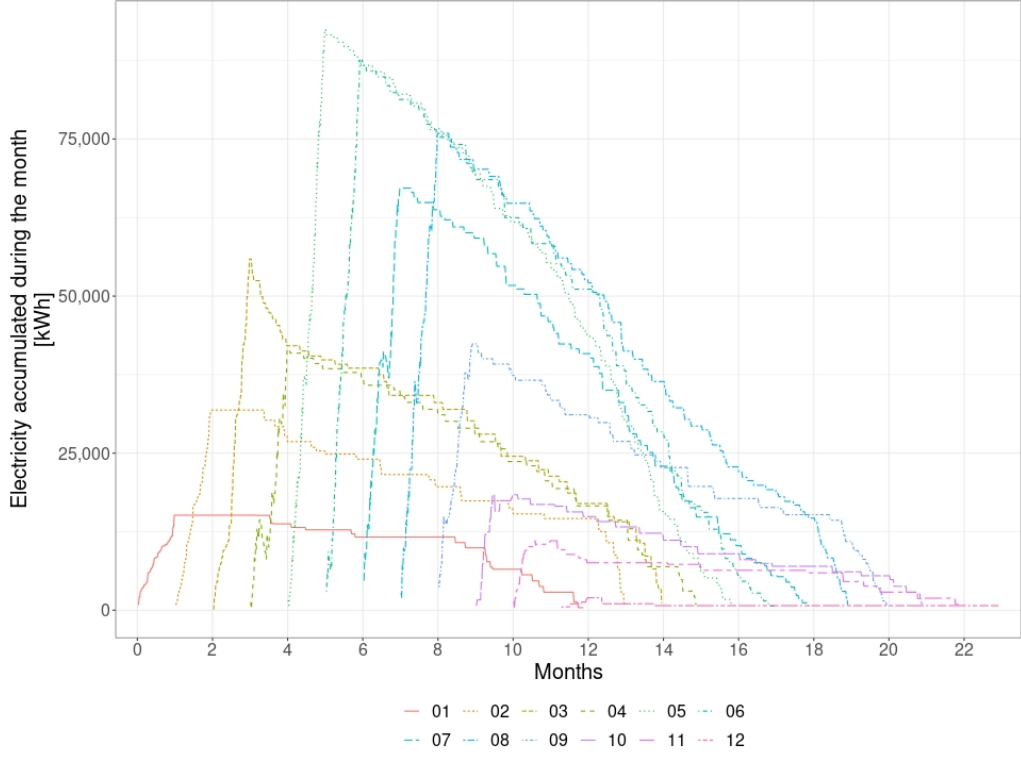
Figure 6. Energy flow in the network deposit for an example energy cooperative using PV for a one-year period of analysis.